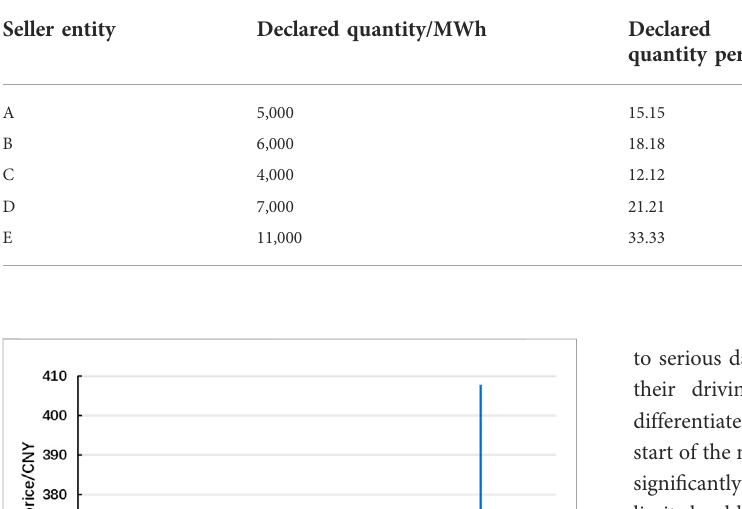
TABLE 4 Seller ’ s winning bid of Scenario 2.